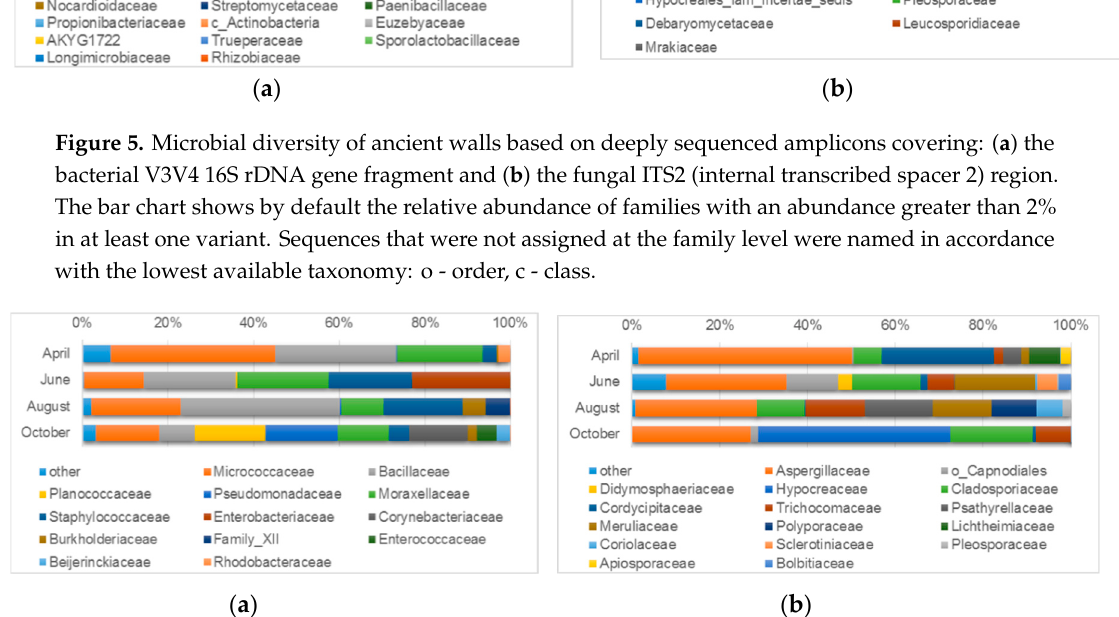
Figure 6. Microbial diversity of indoor air based on deeply sequenced amplicons covering: ( a ) the bacterial V3V4 16S rDNA gene fragment and ( b ) the fungal ITS2 region. The bar chart shows by default the relative abundance of bacterial families with an abundance greater than 2% in at least one variant. Sequences that were not assigned at the family level were named in accordance with the lowest available taxonomy: o - order.